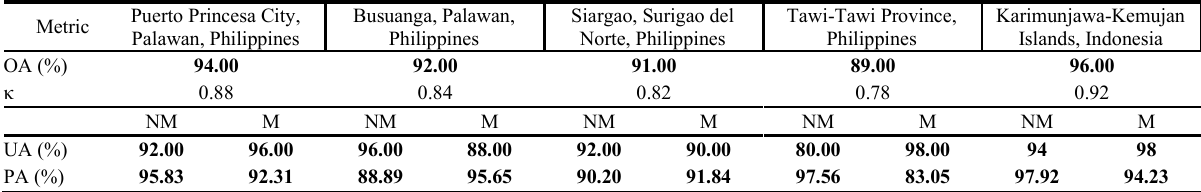
Table 2. Accuracy Assessment Results of Random Forest (RF) Classified PlanetScope Images. Figure 4 provides insights into the separability of mangroves